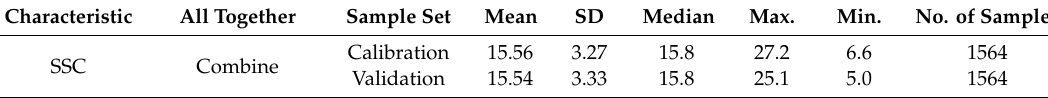
Table 5. Statistical properties of SSC for combine